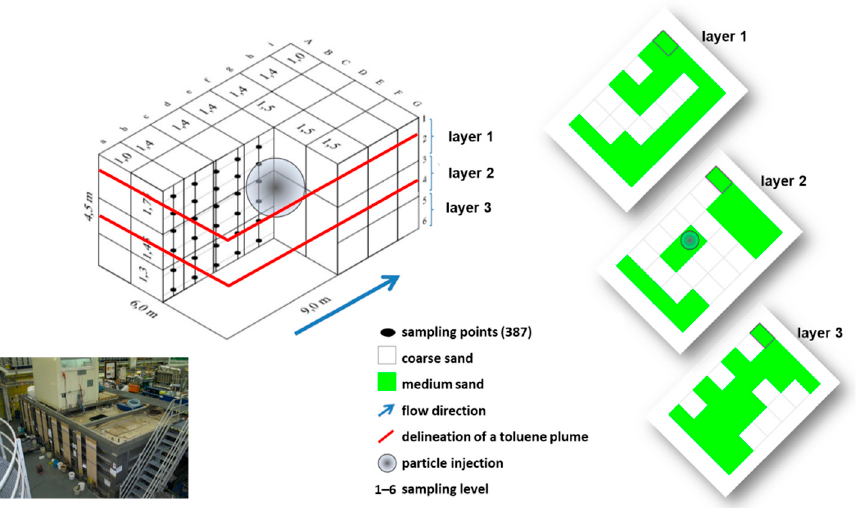
Figure 1. Container layout (plan and cross-section view) indicating injection well and sampling ports. Table 1. Characteristics of the heterogeneous aquifer (medium and coarse sand).